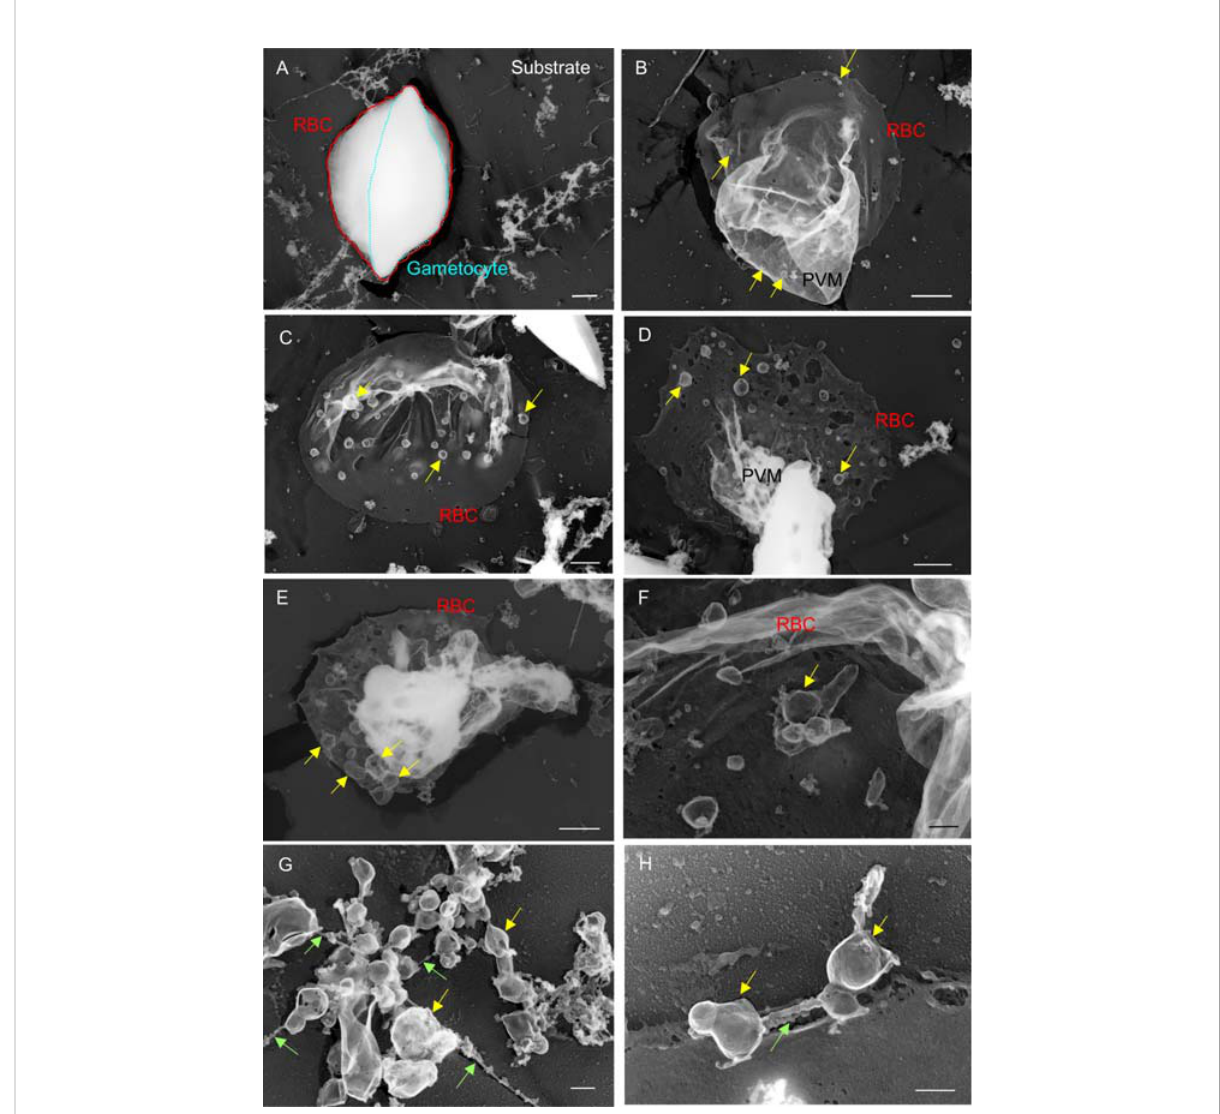
FIGURE 5 Electron microscopy observations of unroofed gametocytes (A) Example of insuf fi ciently unroofed gametocytes. The whole gametocyte structure remained intact after the unroo fi ng process. (B – H) Properly unroofed gametocytes. In some cases, gametocyte bodies were also removed by the unroo fi ng process, leaving erythrocyte membranes and associating exo-membranes, depending on the force applied to the cells or variations in the rigidity of individual cells (e.g., c). Bubbles of various sizes appeared on the PVM or interior side of erythrocyte membranes (b – f; yellow arrow). (G, H) MC-like objects (yellow arrow) found on erythrocyte membranes. The MC-like objects were bound to each other by tethers (green arrow). These objects were similar in size; however, some were smaller than those found on asexual MCs. Bar = 1 µm (A – E) , 200 nm (F – H)